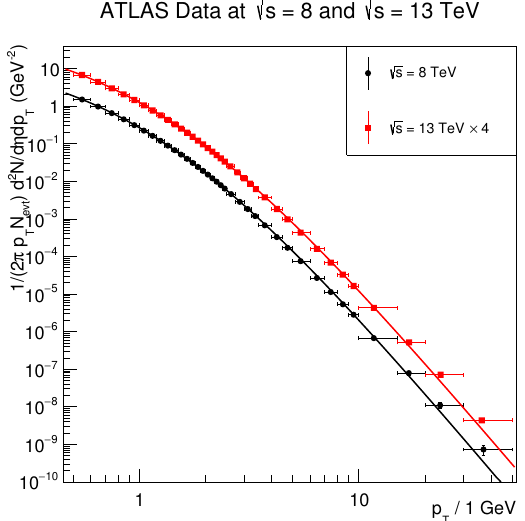
Figure 6. Fit of inclusive double-di(cid:11)erential charged hadron production cross sections obtained in proton-proton collisions at center of mass energy p s = 8 and p s = 13 TeV by the ATLAS Collaboration, presented in [94] and [93], respectively. The 13 TeV dataset is rescaled by a factor of four for visual clarity. The data are displayed alongside (cid:12)ts to the model in eq.